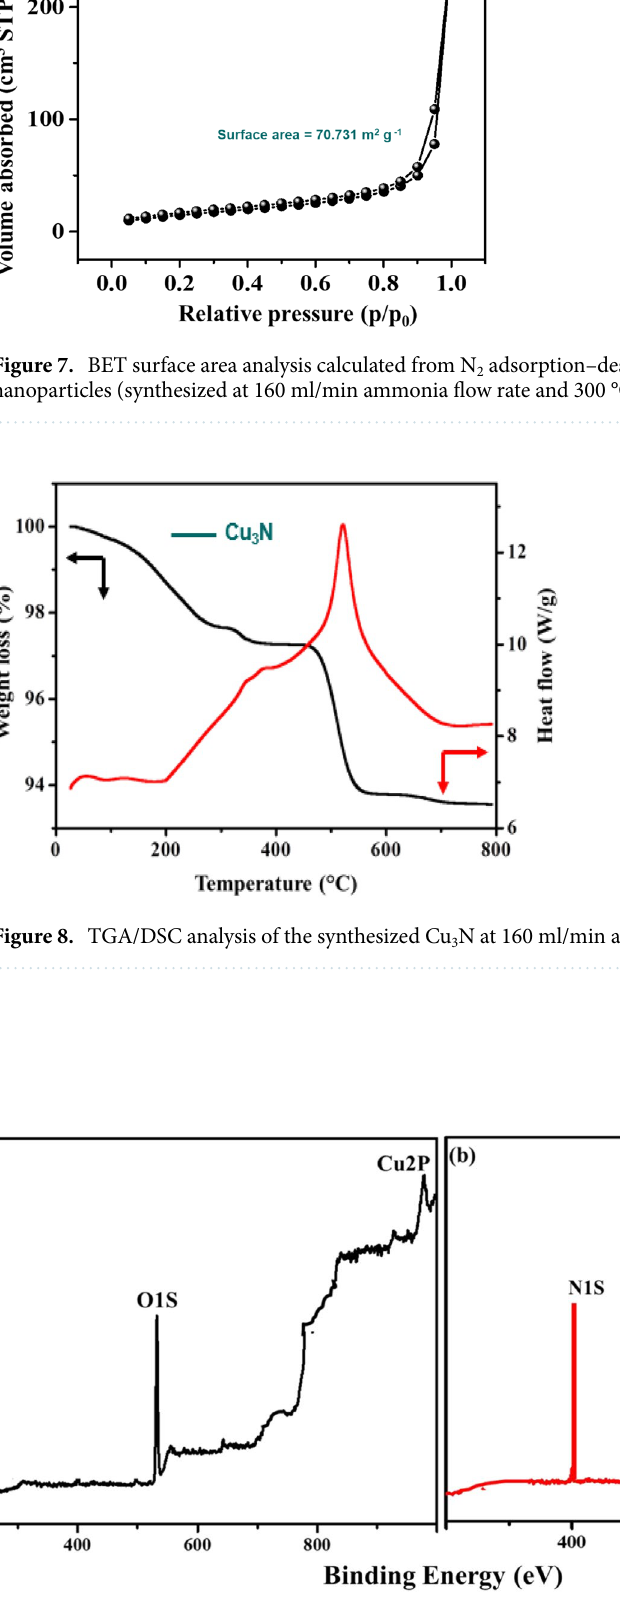
Figure 9. X-Ray photoelectron spectroscopy analysis of ( a ) Cu 2 O, ( b ) Cu 3 N (synthesized at 160 ml/min ammonia flow rate and 300